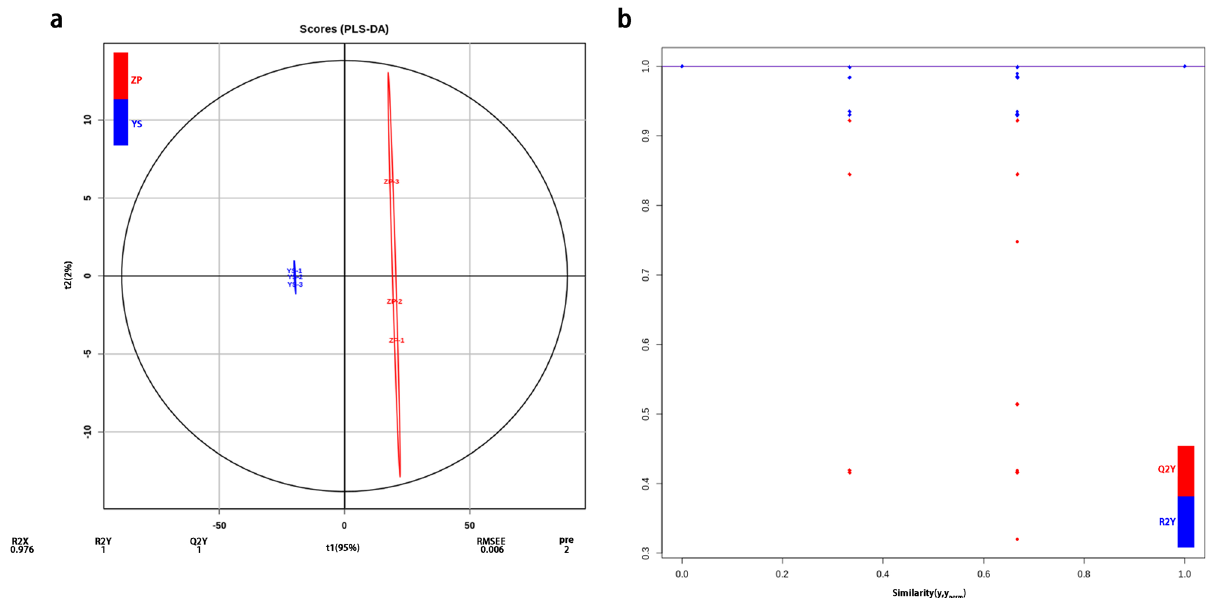
Figure 2. ( a ) OPLS-DA score Plot. t1: Predicted principal components-score value of main components and difference between observation groups, t01: Orthogonal principal component-score value of orthogonal components and difference in observation group, R 2 Y: Percentage of Y matrix information that can be explained by OPLS-DA, Q 2 Y (Q 2 ): Prediction ability of OPLS-DA, Pre: Predicted principal component number, RMSEE: Root mean squared error, Red: ZP, Blue: YS. ( b ) OPLS-DA permutation verification plot. Red: Q 2 Y, Blue: R 2 Y. OPLS-DA score Plot visualized in ggplot2 toolkit of R v1.0.1 (https:// www.r- proje ct.